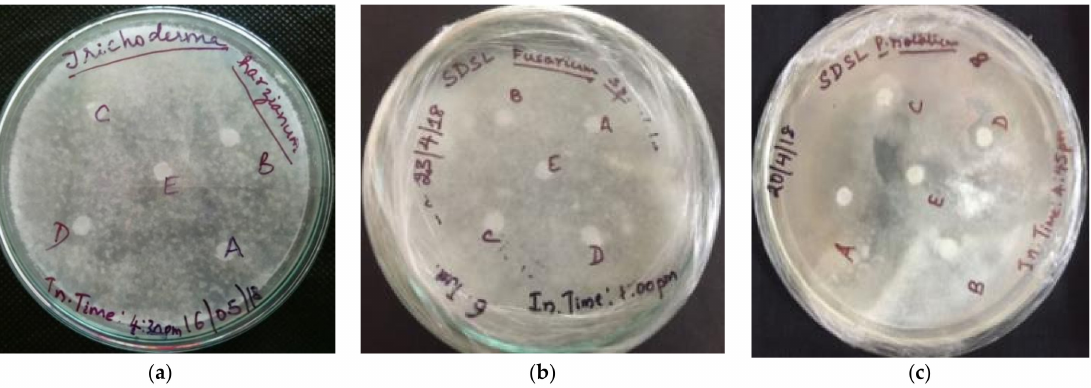
Figure 11. Disc diffusion assay testing for the antifungal activity ( a ) Trichoderma harzianum ( b ) Fusarium oxysporum and ( c ) Penicillium notatum .